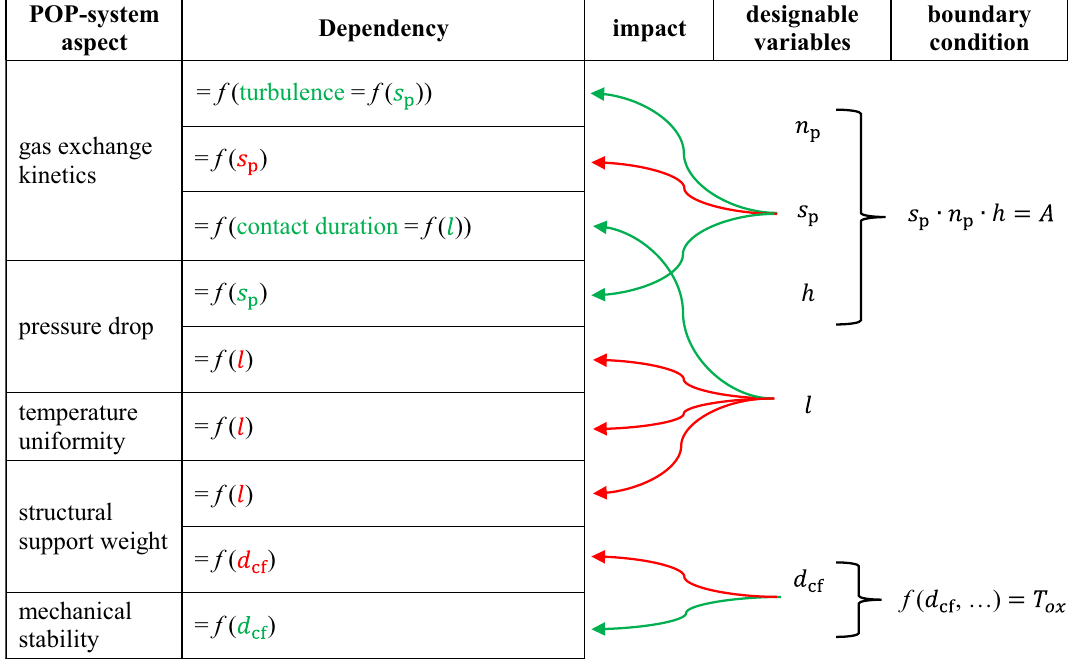
Table 4. Some interdependencies between reactor chamber variables and important aspects of the POP